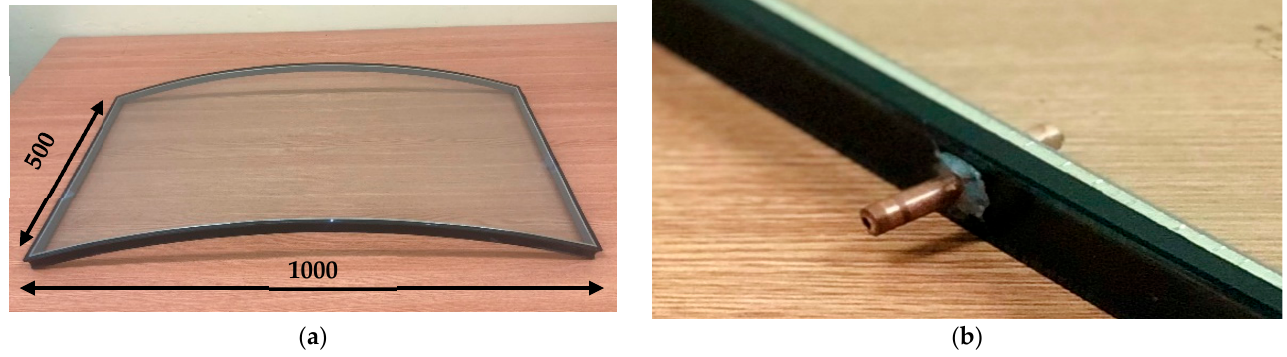
Figure 1. Experimental study: ( a ) Curved IGU sample; ( b ) Copper tube glued into a hole drilled in the spacer.